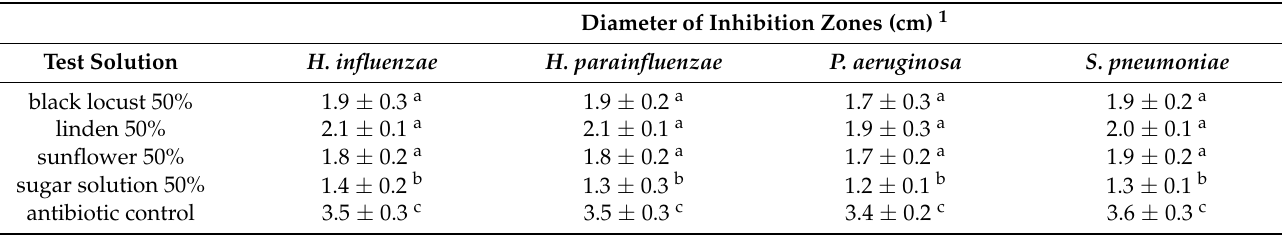
Table 3. Results of the agar well diffusion assay with 50% honey and sugar solutions, compared to antibiotics as positive control. Inhibition of bacterial growth was indicated by the appearance of a zone of inhibition around the well.